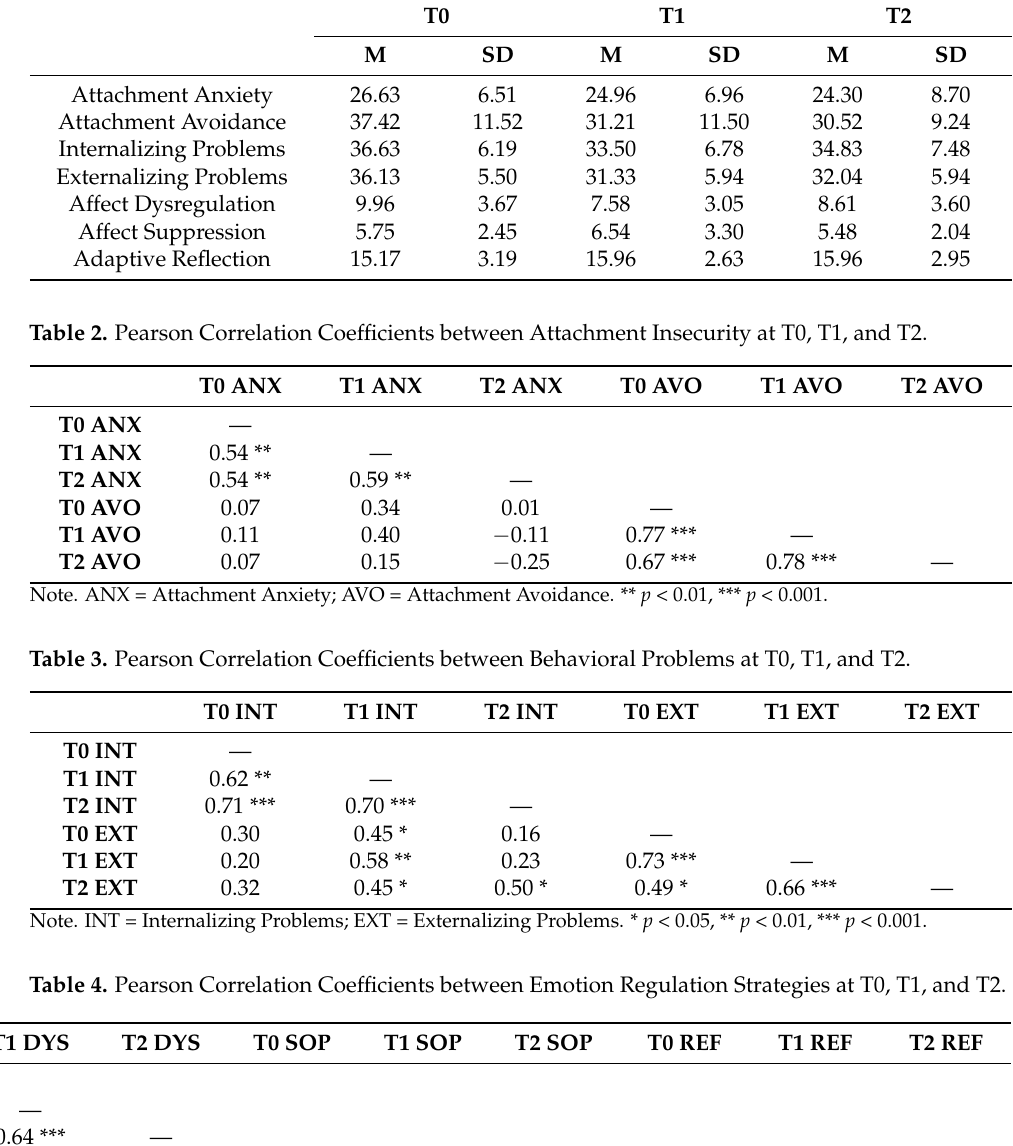
Table 1. Means and Standard Deviations for Attachment Insecurity, Behavioral Problems, and Emotion Regulation Strategies at T0, T1, and T2. T0